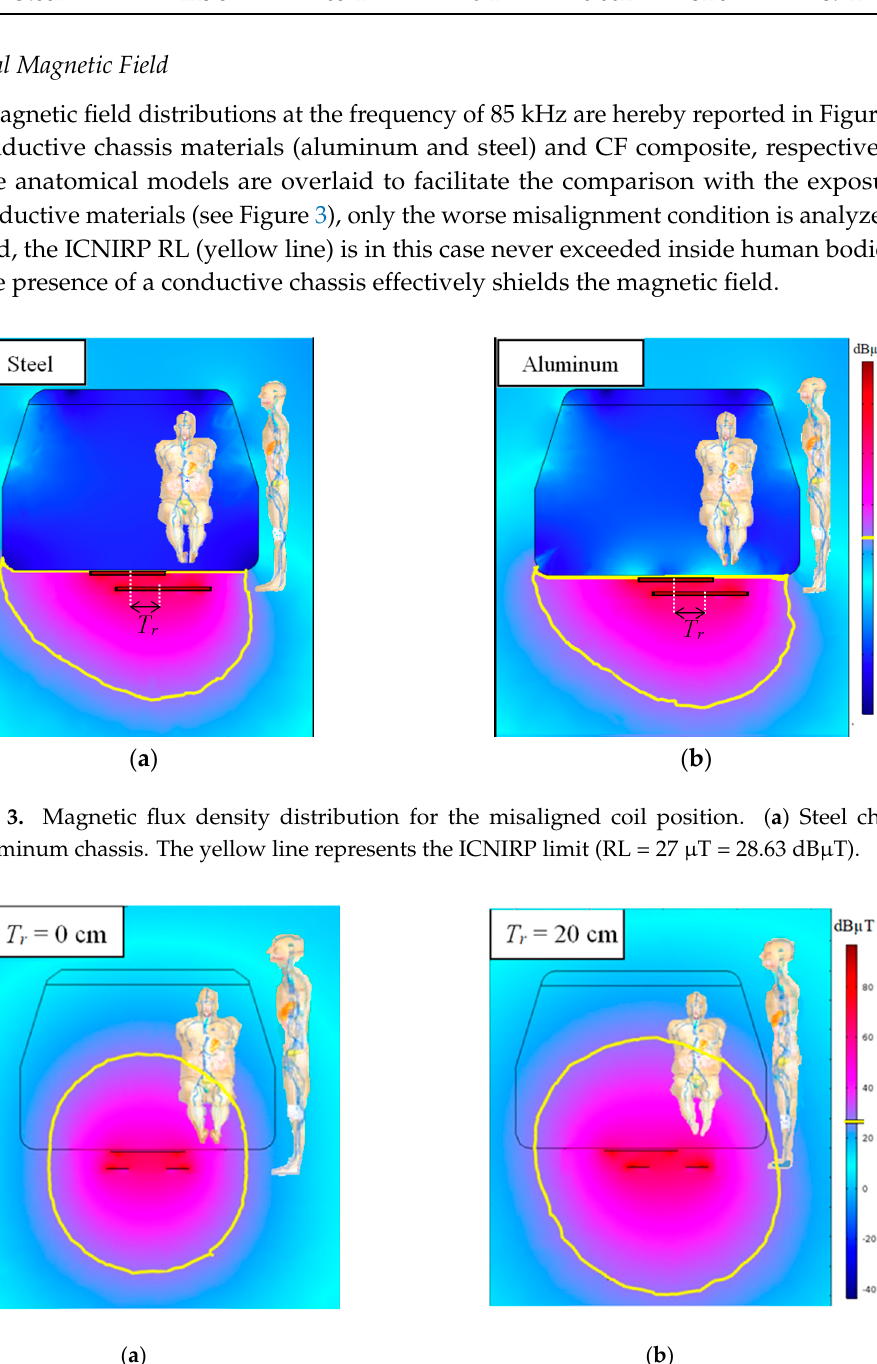
Table 4. Maximum magnetic field for both anatomical models